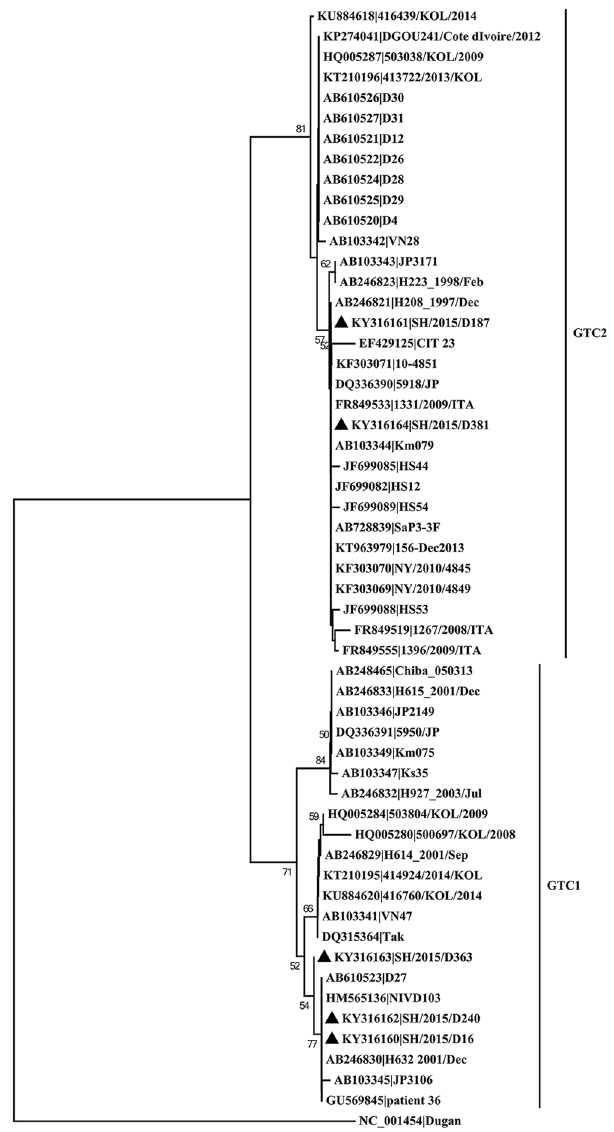
Figure 3. Phylogenetic tree based on the HVRs of the HAdV-41 hexon genes of reference strains from previous studies and our isolates from Shanghai. Forty-three HAdV-41 isolates with partial hexon sequences are also included and indicated with accession numbers and